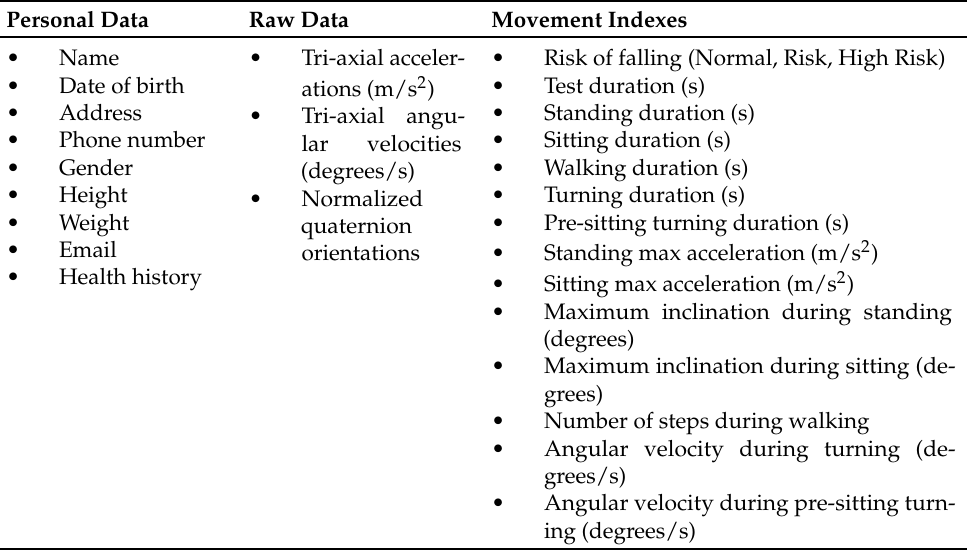
Figure 5. iTUG test with each phase segmented: (1) Standing, (2) Go walking, (3) 3 m mark turning, (4) Return walking, (5) Turn before sitting, and (6) Sitting. Note that the sensor is located on the lower-back of the person. Table 2. Available information in the proposed movement analysis system by the iTUG for risk of falls